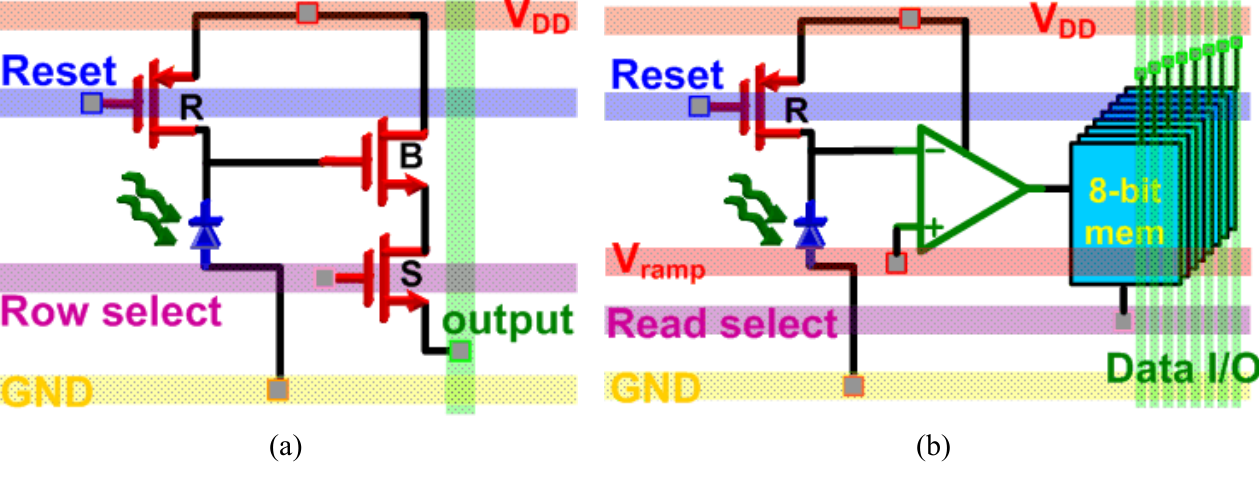
Figure 5. Simplified schematic diagrams of (a) a 3-T active pixel sensor (APS) and (b) a digital pixel sensor (DPS) containing part of the ADC and an 8-bit memory within the